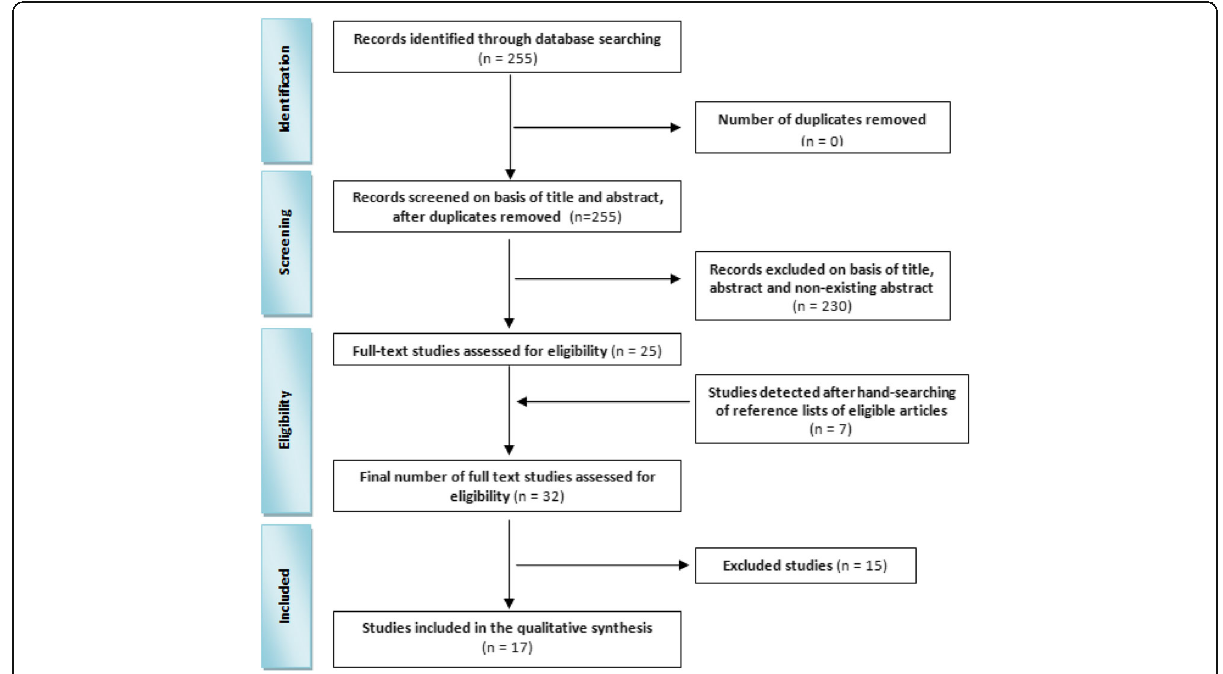
Fig. 1 The PRISMA flow diagram for the selection of